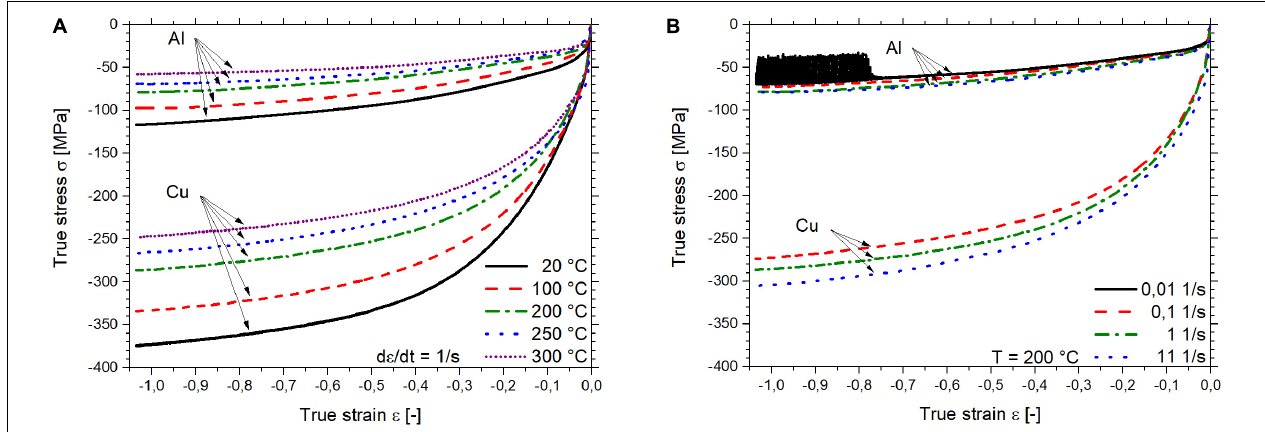
FIGURE 2 | True stress-true strain curves of EN AW-1080A and CW004A: (A) at a constant logarithmic strain rate of ˙ ε = 1 s − 1 ; (B) at a constant temperature of T = 200 ◦ C.